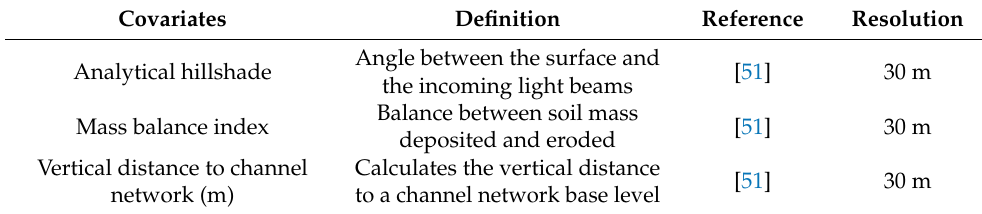
Table A1. A list of environmental covariates used to predict soil heavy